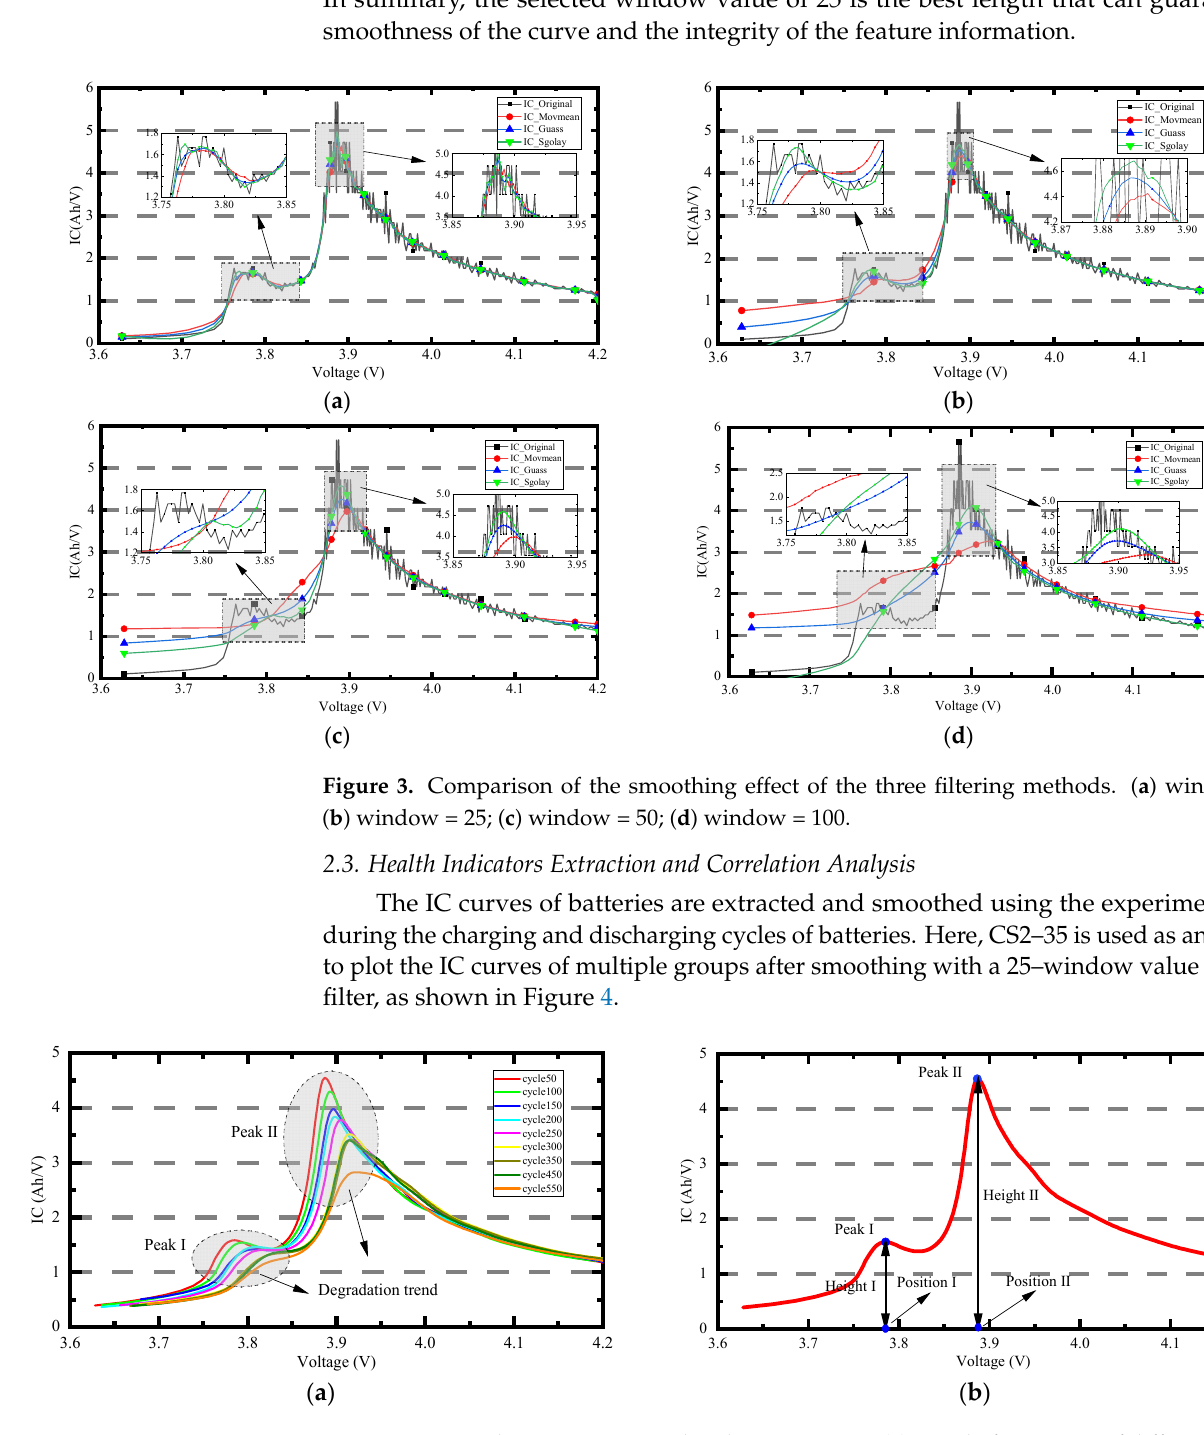
Figure 4. CS2–35 battery aging trend and HI extraction . ( a ) Trend of IC curves of different cycles of CS2–35; ( b ) schematic of IC curve HIs.